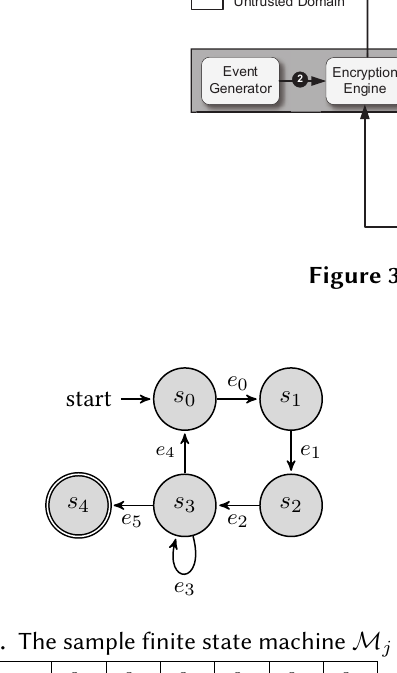
Figure 5. The transition function M j . ∆